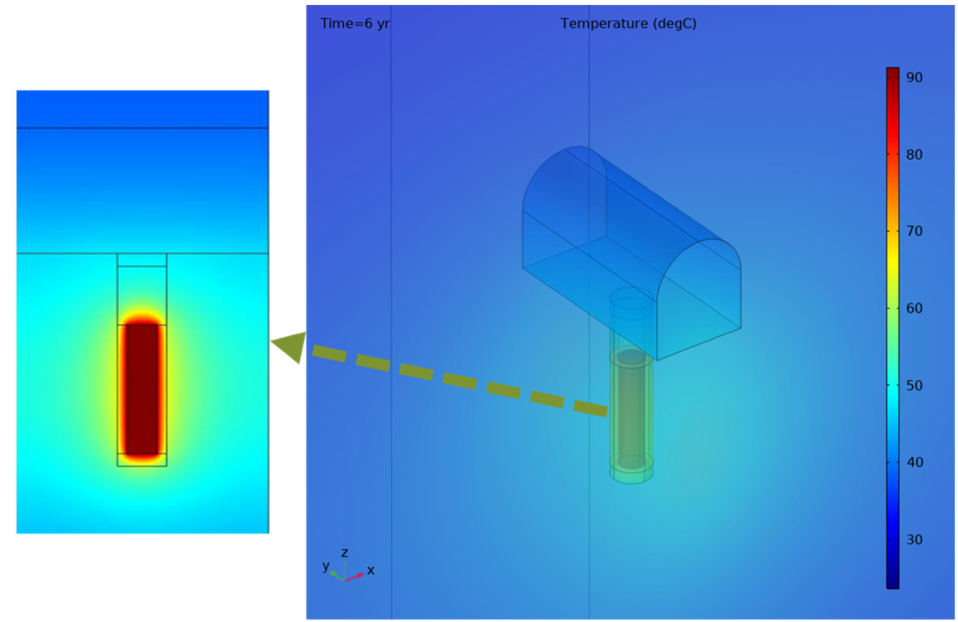
Figure 10. Temperature profile at six years for the simulation